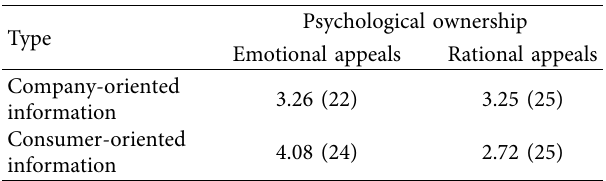
Table 2: Moderation of advertising information expression (re- search